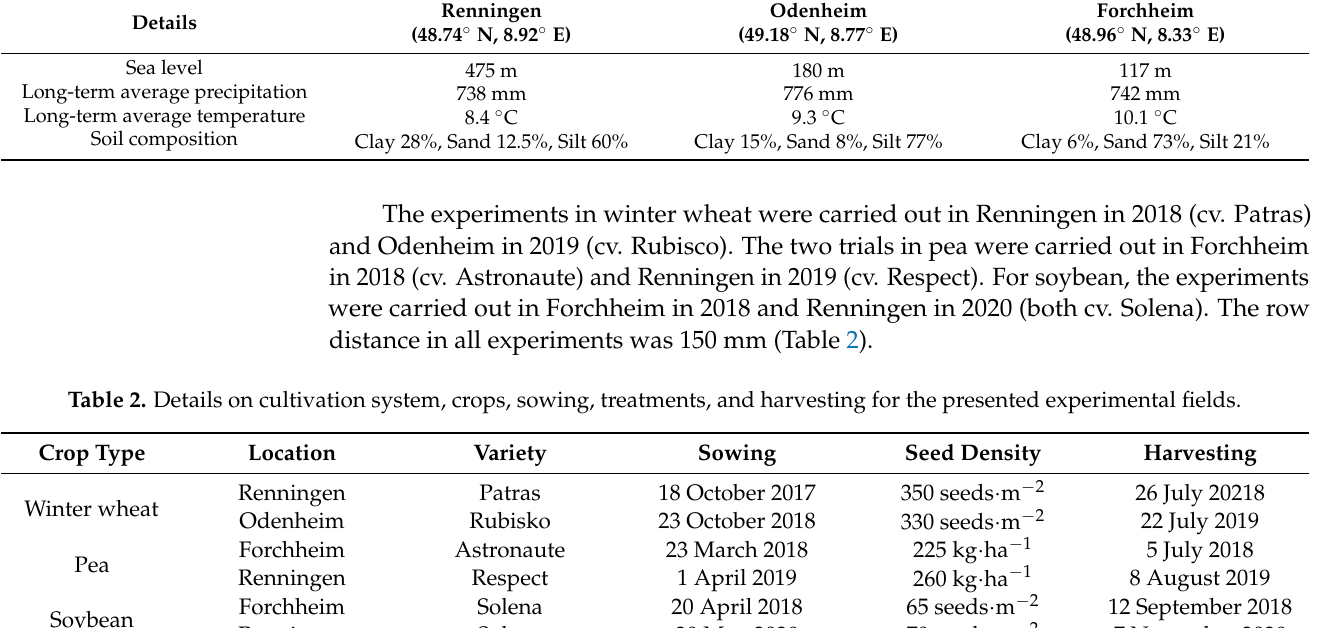
Table 1. Site conditions for the three research locations Renningen, Odenheim, and Forchheim. Details Sea level Long-term average precipitation Long-term average temperature Soil composition